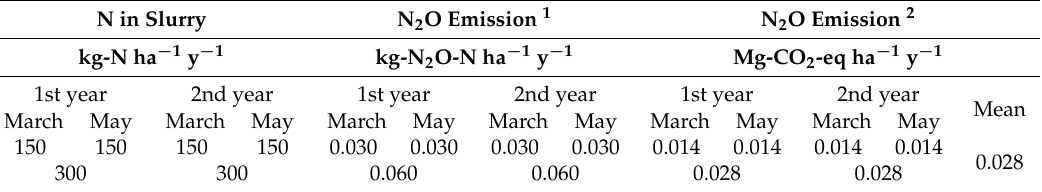
Table 5. Emission of N 2 O related to storage of cattle